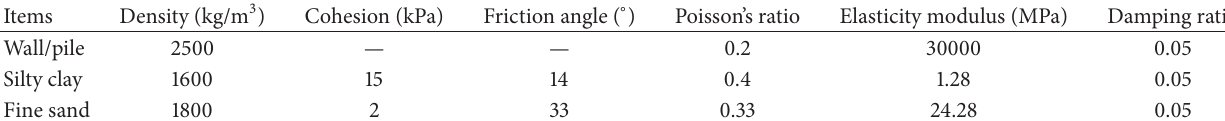
Table 2: Static and dynamic parameters of structure and bed soil.